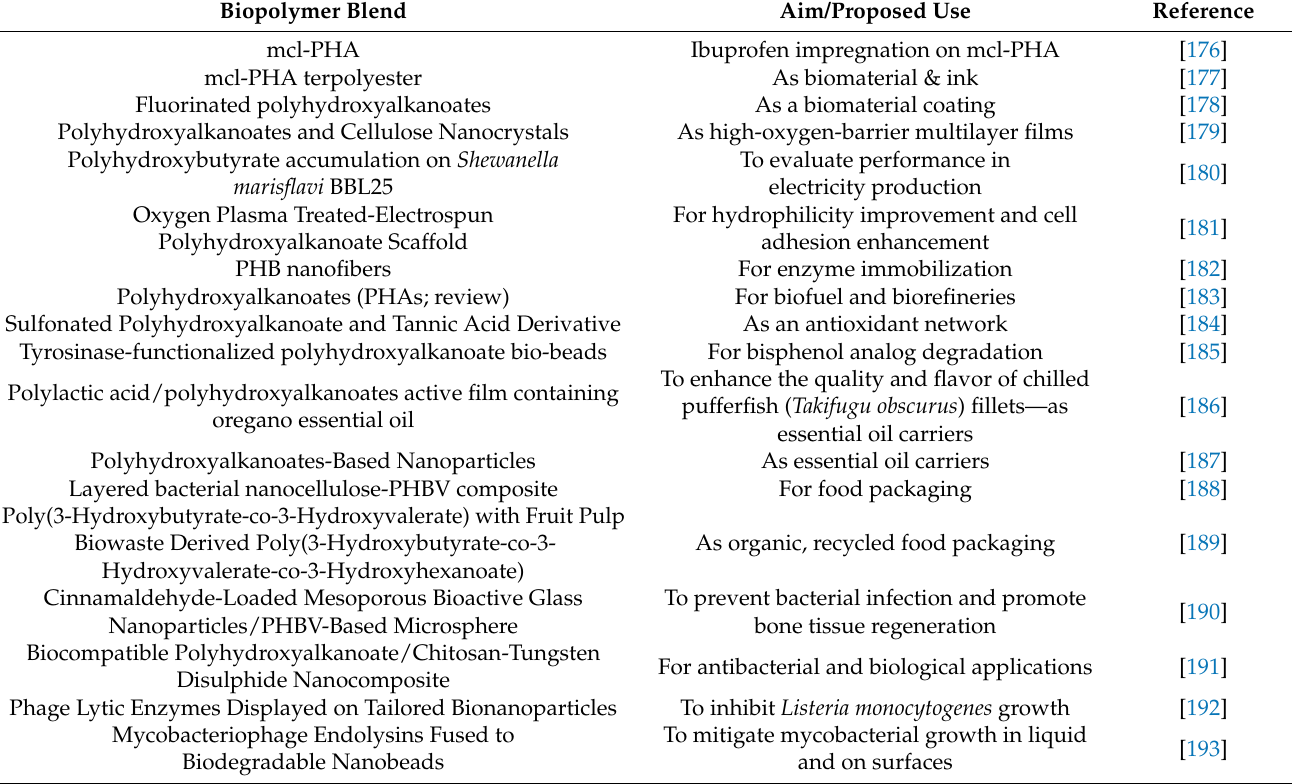
Table 2. Other novel uses for PHA